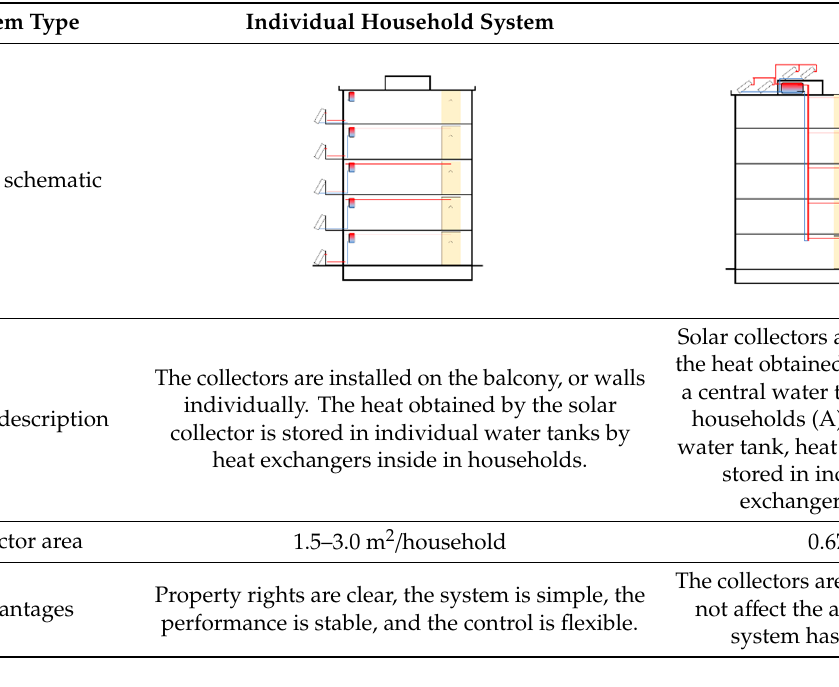
Table 2. Types of solar water heating (SWH) systems commonly used in high-rise buildings.